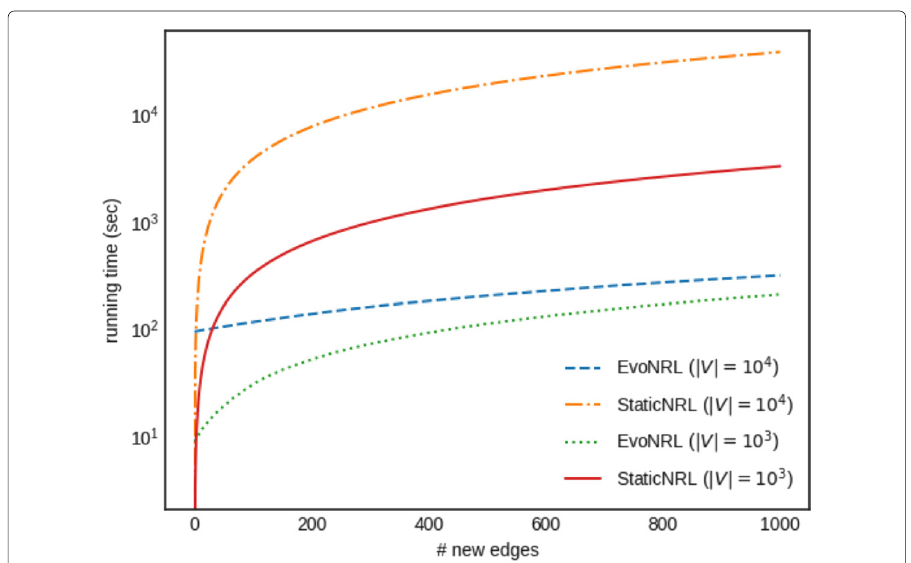
Fig. 16 E VO NRL scalability (running time axis is in logarithmic scale). StaticNRL scales linearly to the number of new edges added in the network, since it has to run again and again for every new edge. At the same time, E VO NRL is able to accommodate the changes more than 100 times faster than StaticNRL. This behavior is even more stressed in the larger network (where the number of nodes is larger)